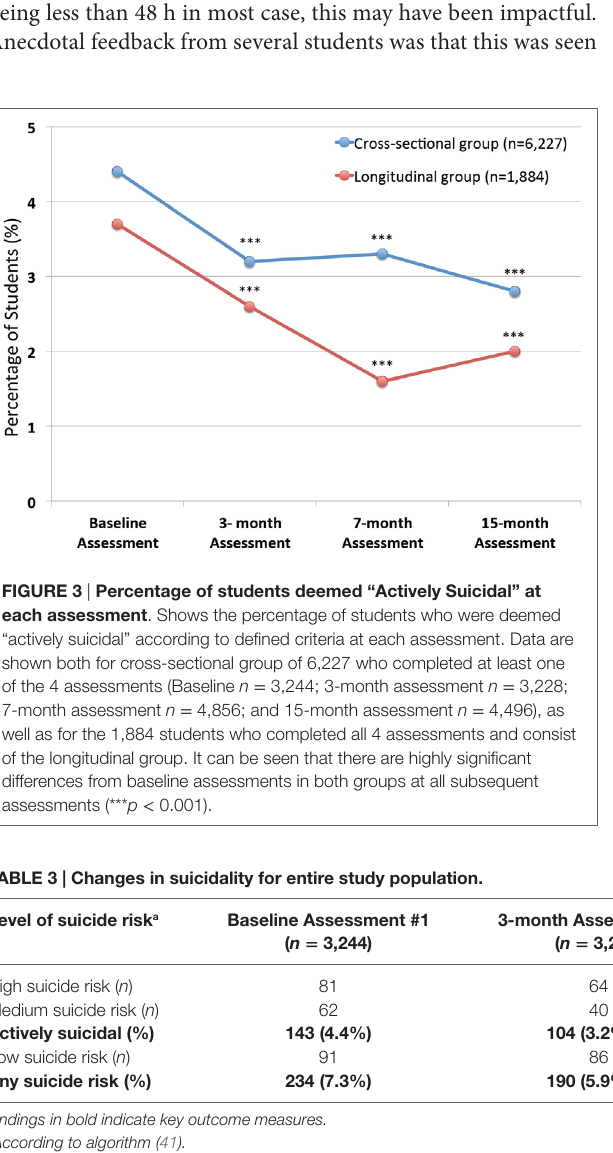
Findings in bold indicate key outcome measures. a According to algorithm (41).